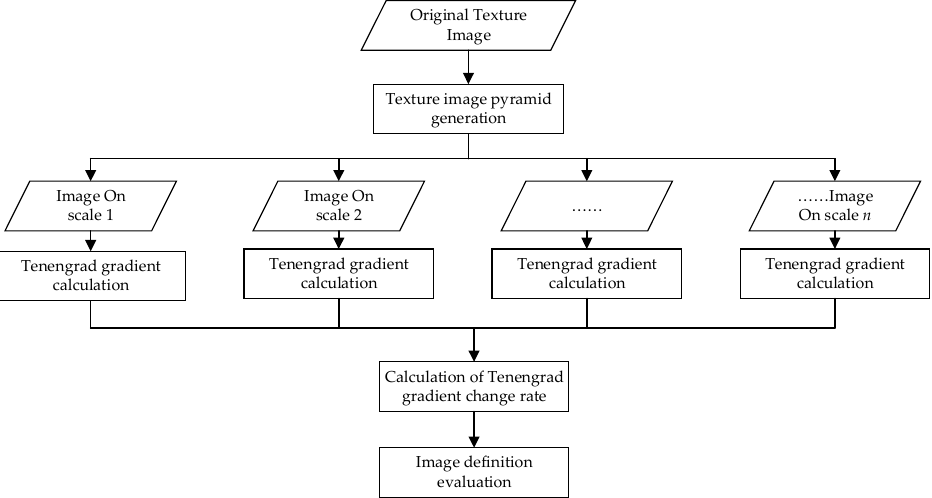
Figure 3. Definition evaluation model based on Tenengrad gradient change.